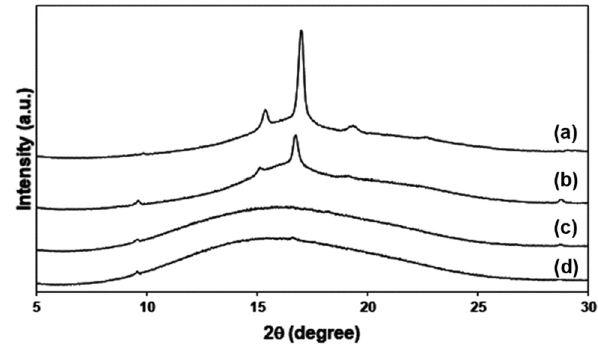
Figure 5: XRD patterns of PLLA - PEG - PLLA fi lms: ( a ) without CE and